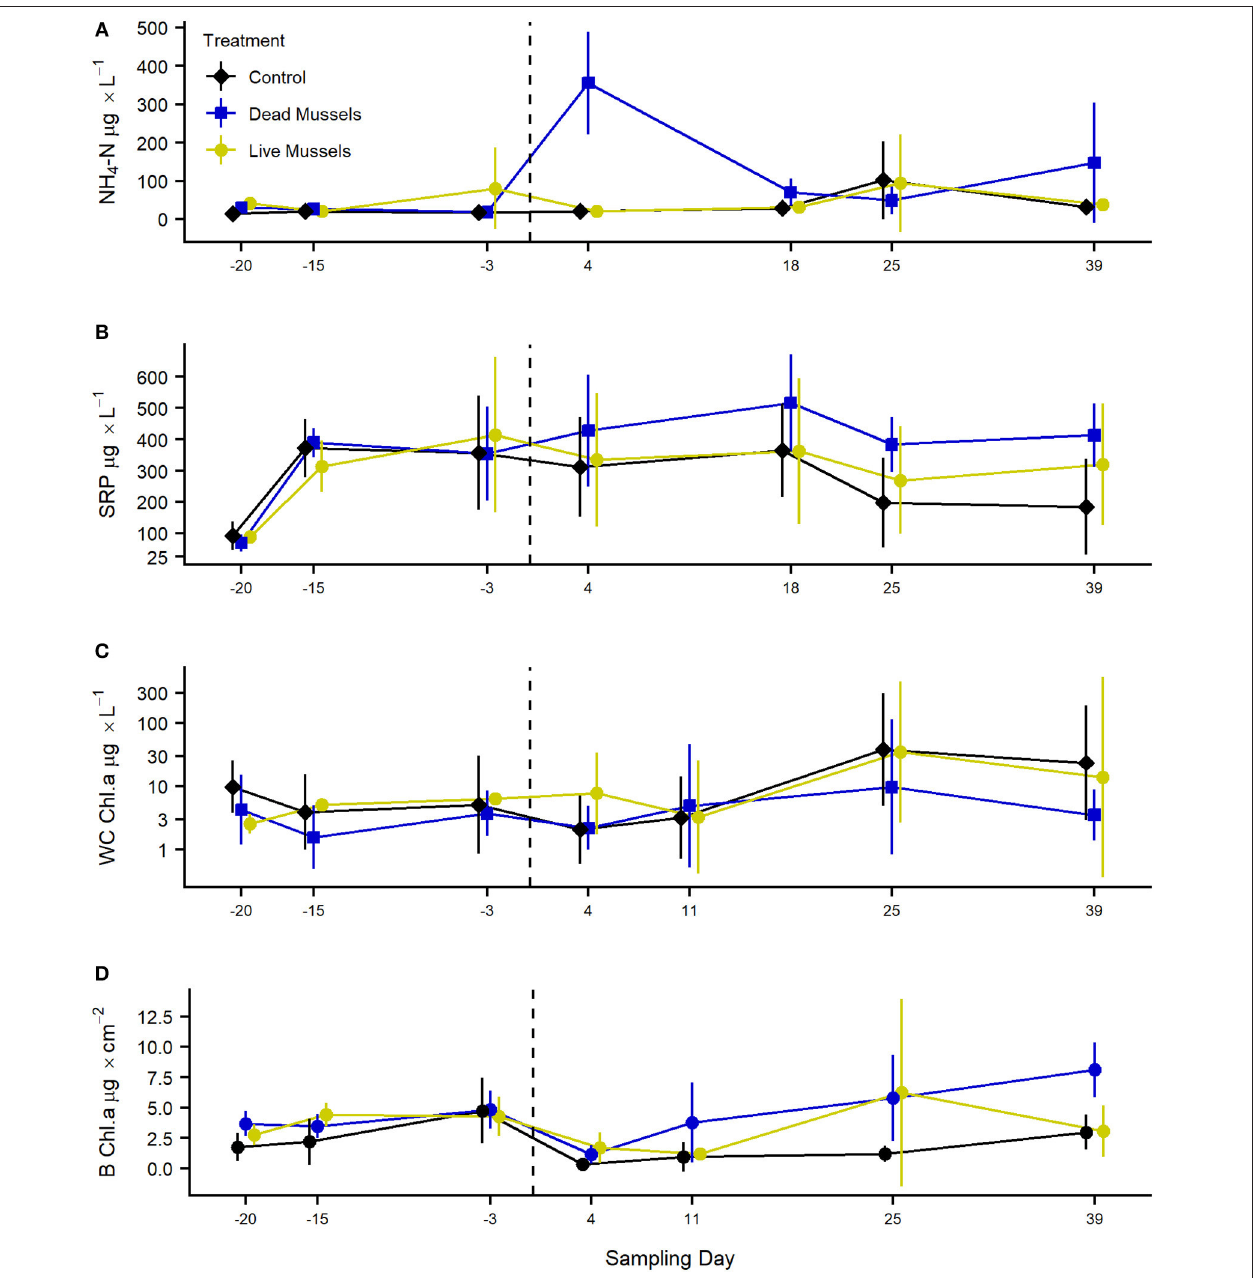
FIGURE 3 | Ambient concentrations of NH 4 -N ( µ g L − 1 ; A ), SRP ( µ g L − 1 ; B ), water column chlorophyll a concentrations ( µ g L − 1 ; C ) and benthic chlorophyll a concentrations ( µ g cm − 2 ; D ) in control, live mussel, and dead mussel treatments. The dashed line represents when the mass mortality event was induced in 5 live mussel mesocosms. Points represent the mean, while the lines indicate the standard deviation. Ammonium is statistically different within control and dead treatments based on a Type III ANOVA, Tukey HSD, p < 0.05. Benthic chlorophyll a was higher in live and mortality treatments than control treatments based on a Type III ANOVA, Tukey HSD, p <